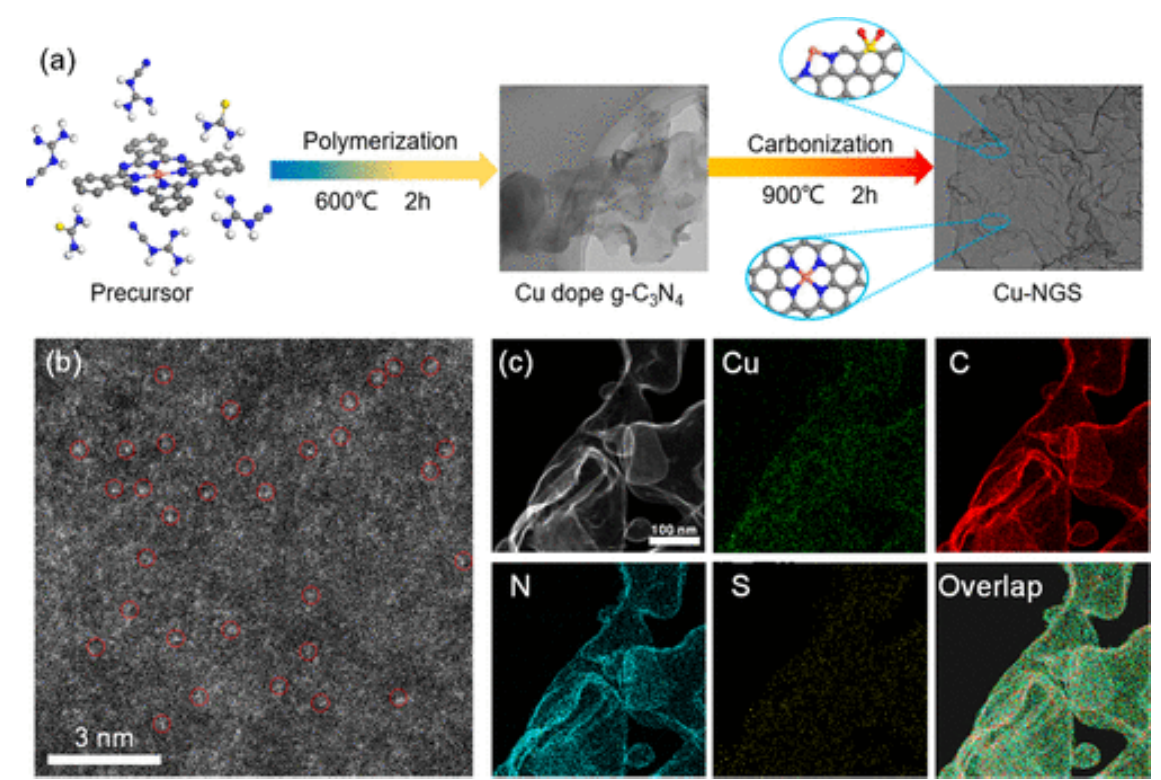
Figure 5. ( a ) The synthesis schematic of the atomically dispersible Cu-Nx site catalyst. The blue, yellow, pink, red, gray, and white spheres represent N, Cu, S, O, C, and H atoms, respectively. ( b ) Atom solution HAADF-STEM imaging of Cu-NGS. Single Cu atoms are highlighted by the red circles. ( c ) STEM-EDS elemental mapping of Cu-NGS. (Reprinted with permission from [76]. Copyright 2019, American Chemical